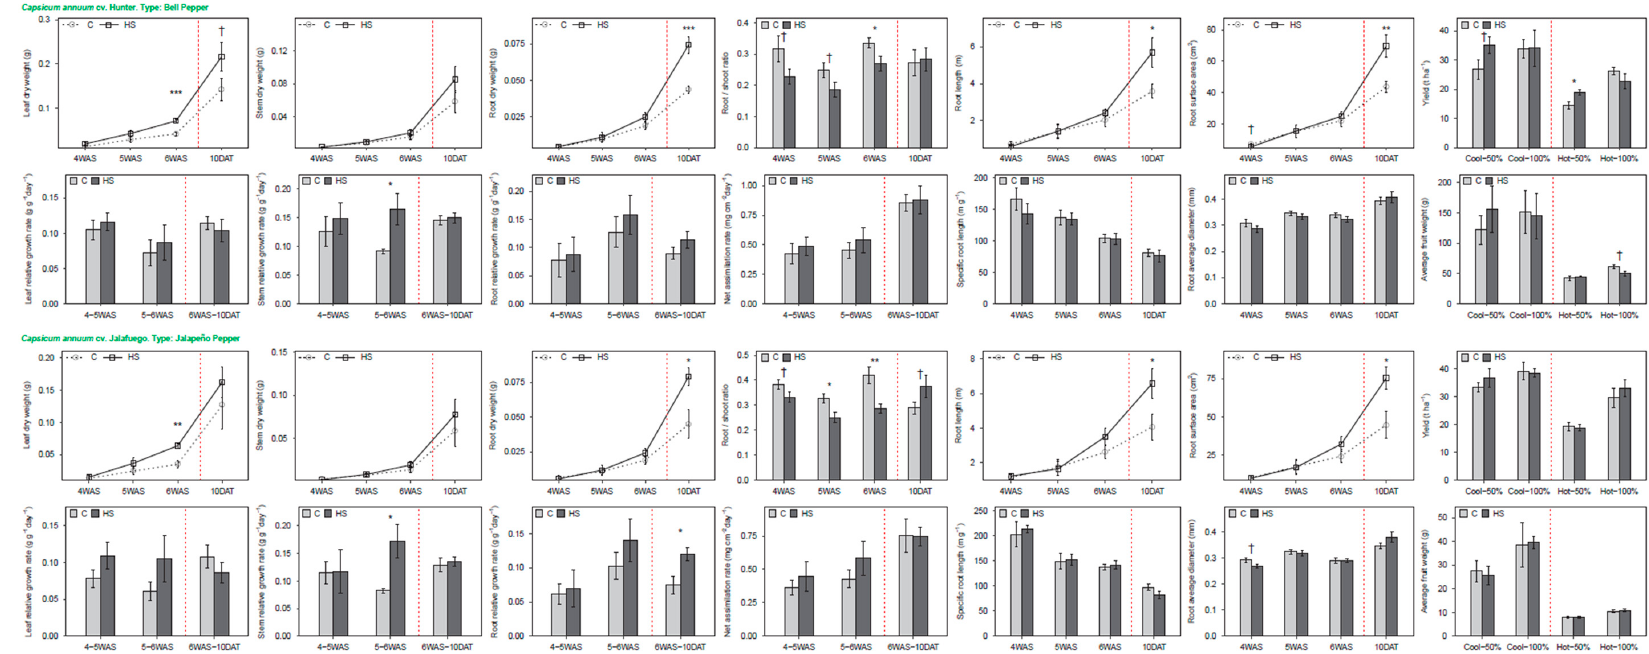
Figure 2. Pepper seedling and transplant quality traits as affected by media amendments, yield traits as affected by amendments and irrigation during the two growing seasons. †, *, **, *** show signi fi cant di ff erence comparing HS to control (C) at P ≤ 0.1, 0.05, 0.01, and 0.001, respectively.